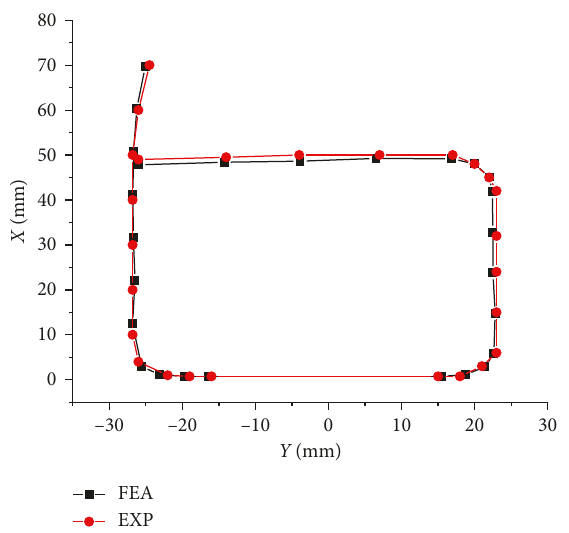
Figure 14: Front shape of b-tube.